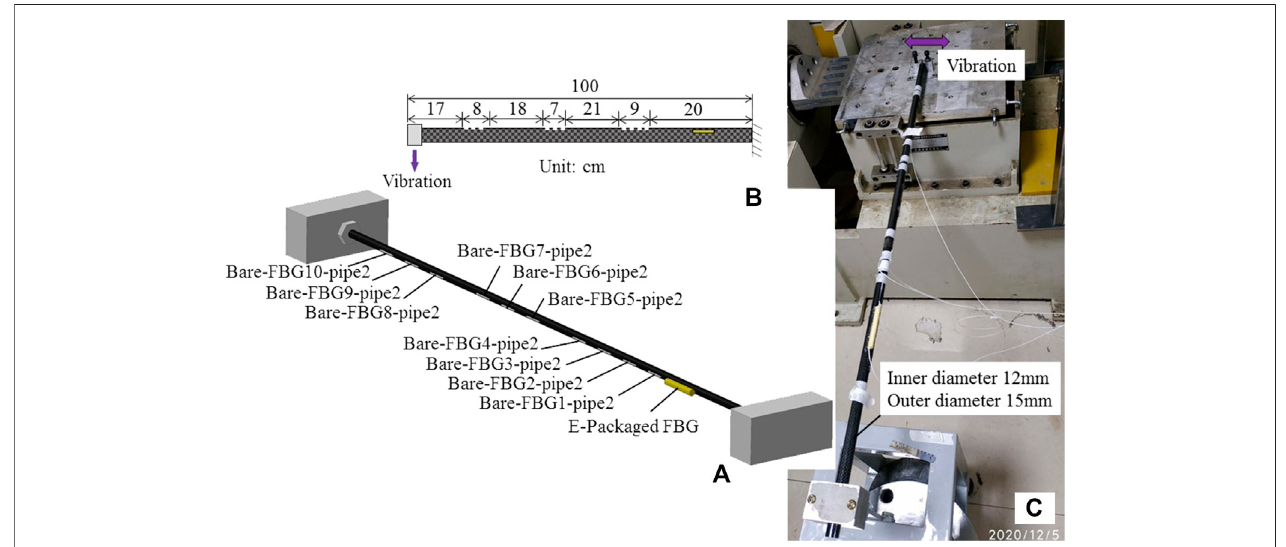
FIGURE 4 | Setup of pipe2: (A) layout of surface-attached FBGs in series; (B) position of FBGs in series; (C) testing photo.